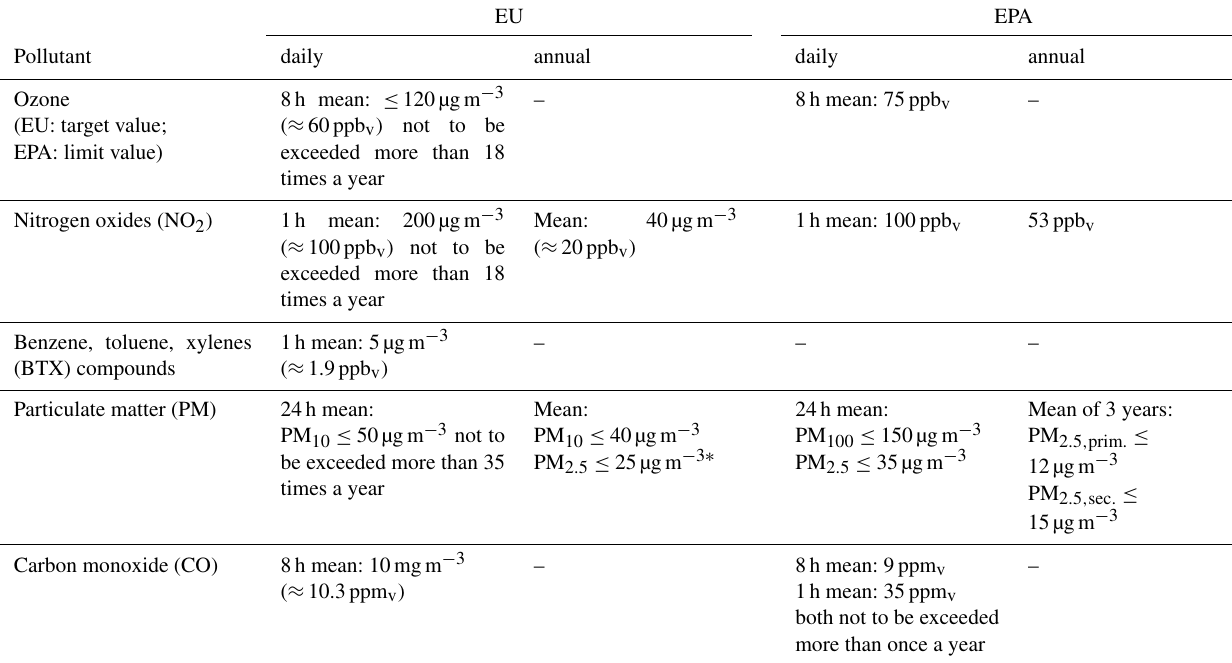
Table 1. European Union (EU) and US (EPA) legislation on selected pollutant concentrations. EU